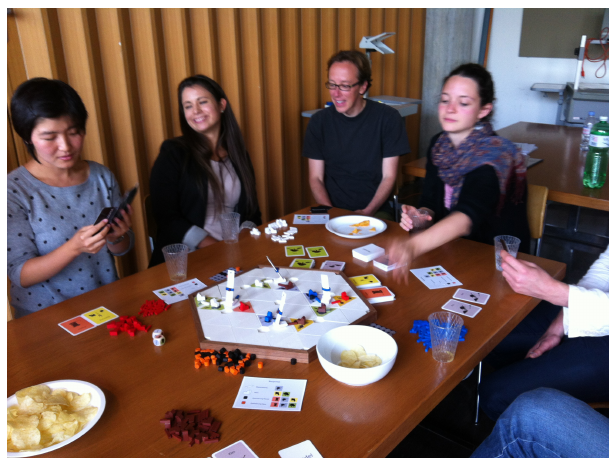
Figure 2. Playing the Wiapuna board game in the final